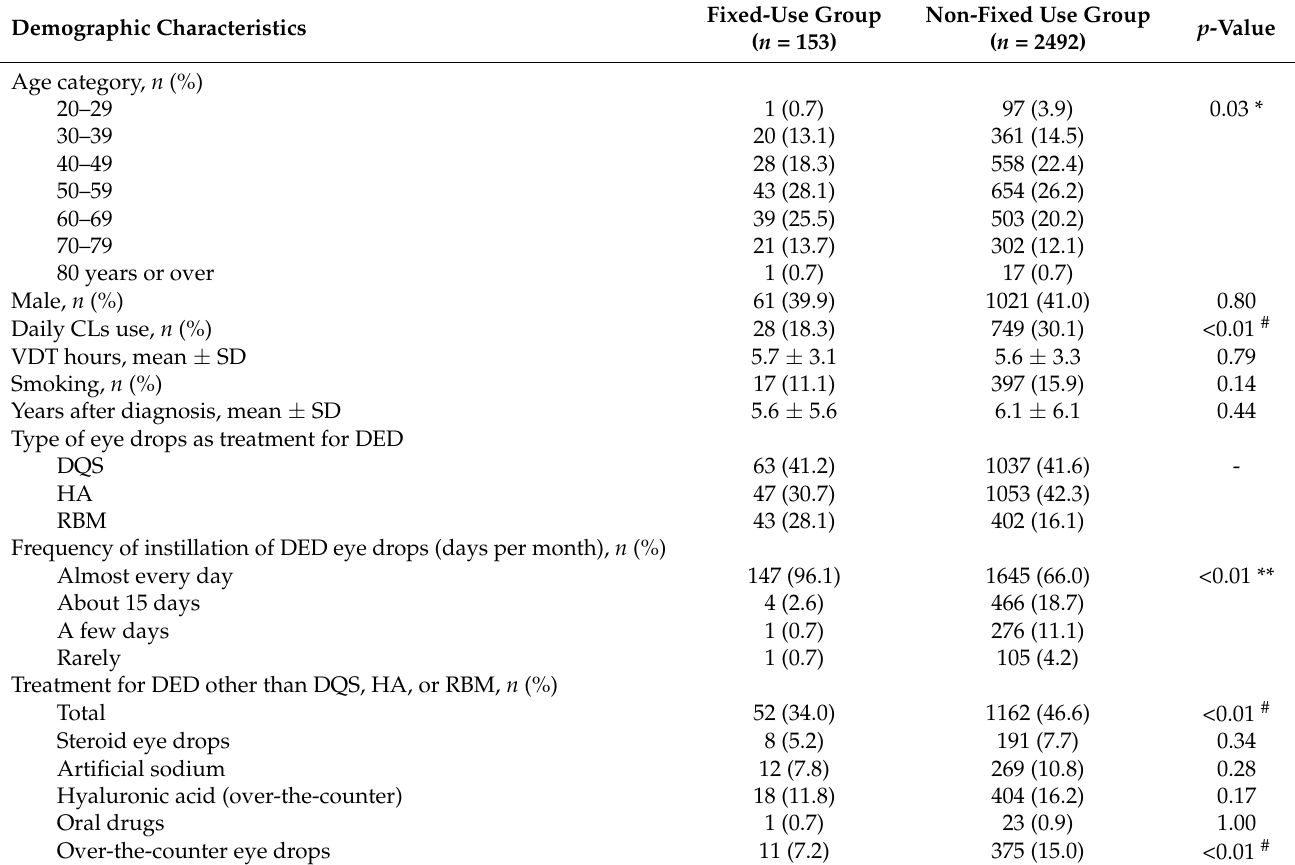
Table 2. Characteristics in the fixed-use group and the non-fixed use group.